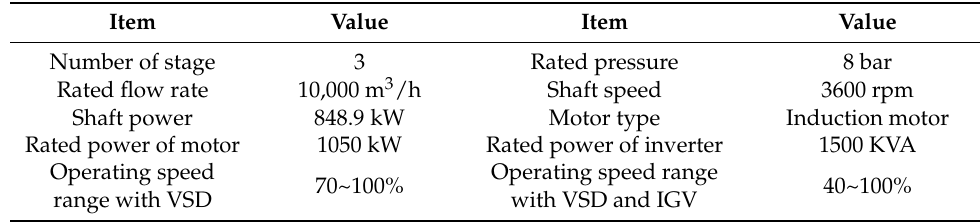
Table 1. Specifications of TACS.